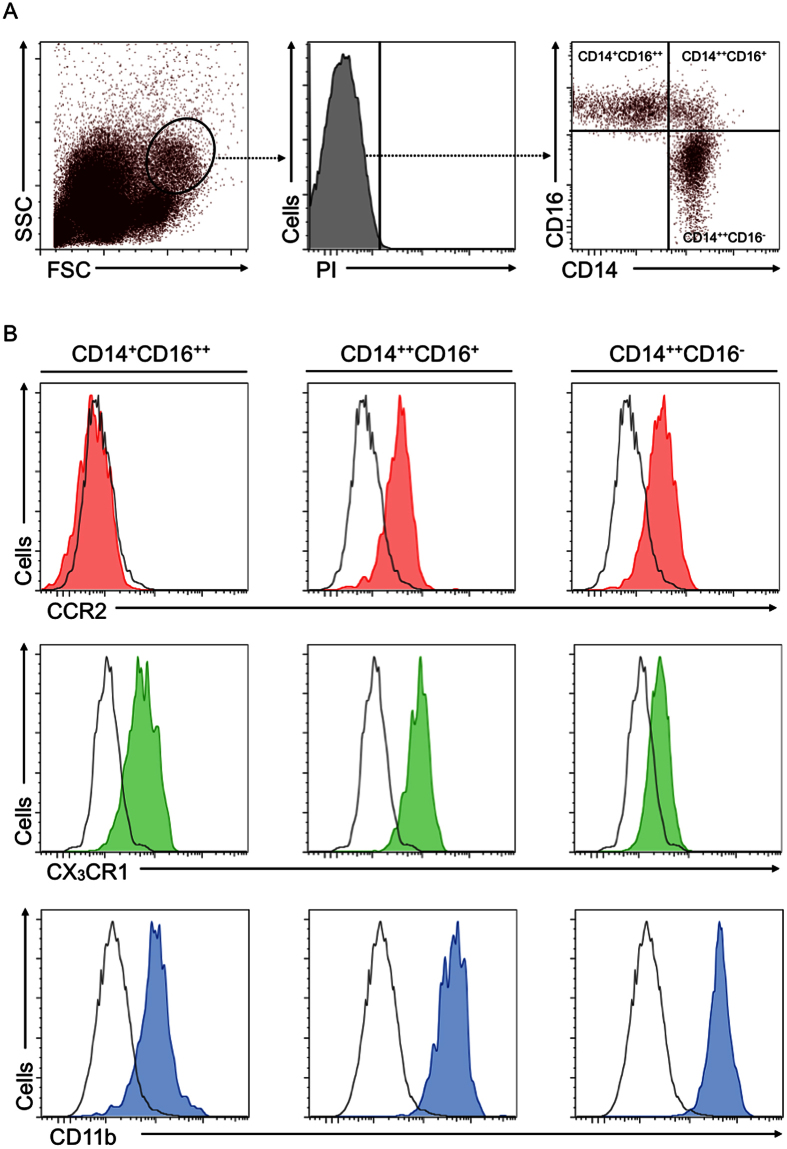
Characterization of monocyte subsets by flow cytometry.Panel A: Human monocytes were identified by flow cytometry by their appearance on the forward-sideward-scatter. Dead cells were excluded by propidium iodine staining. Three major monocyte subsets were identified by their expression of CD14 and CD16. Representative dot plots and histograms are shown. Panel B: Expression of CCR2, CX3CR1 and CD11b were assessed in each of the monocyte subsets and expression levels are depicted in representative histograms; black curve indicate isotype control staining.